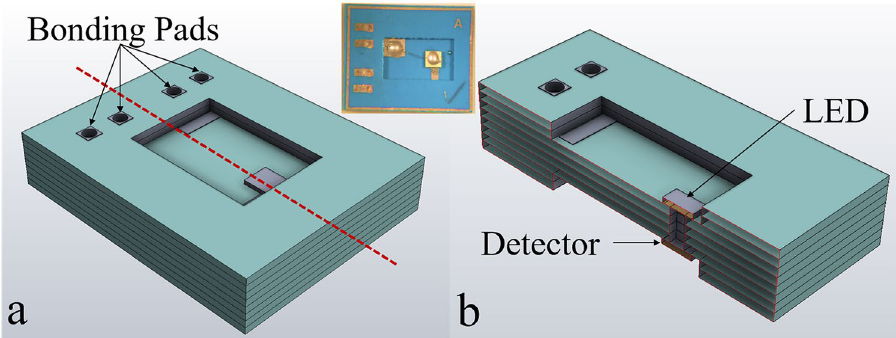
Figure 1. ( a ) 3D CAD design of the LTCC based optocoupler, ( b ) cros sectional view. Inset shows the fabricated